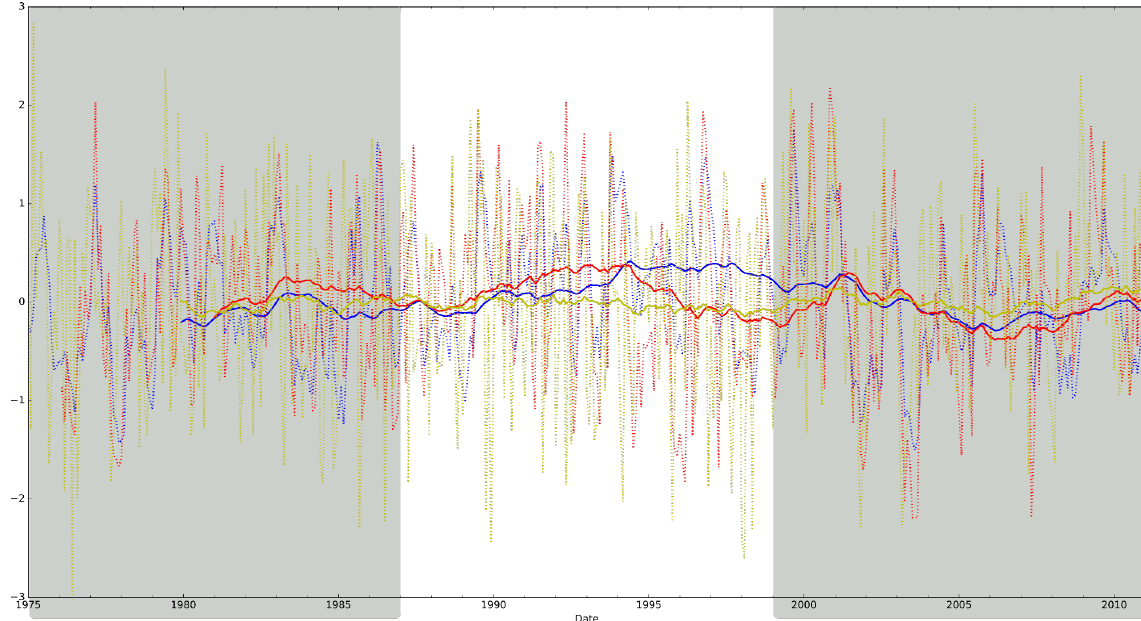
Figure 6. Average values (dotted lines) for the SGI (blue), SPI1 (yellow) and SRSI (red) and their 5-year-running means (solid lines) for the Aichfeld